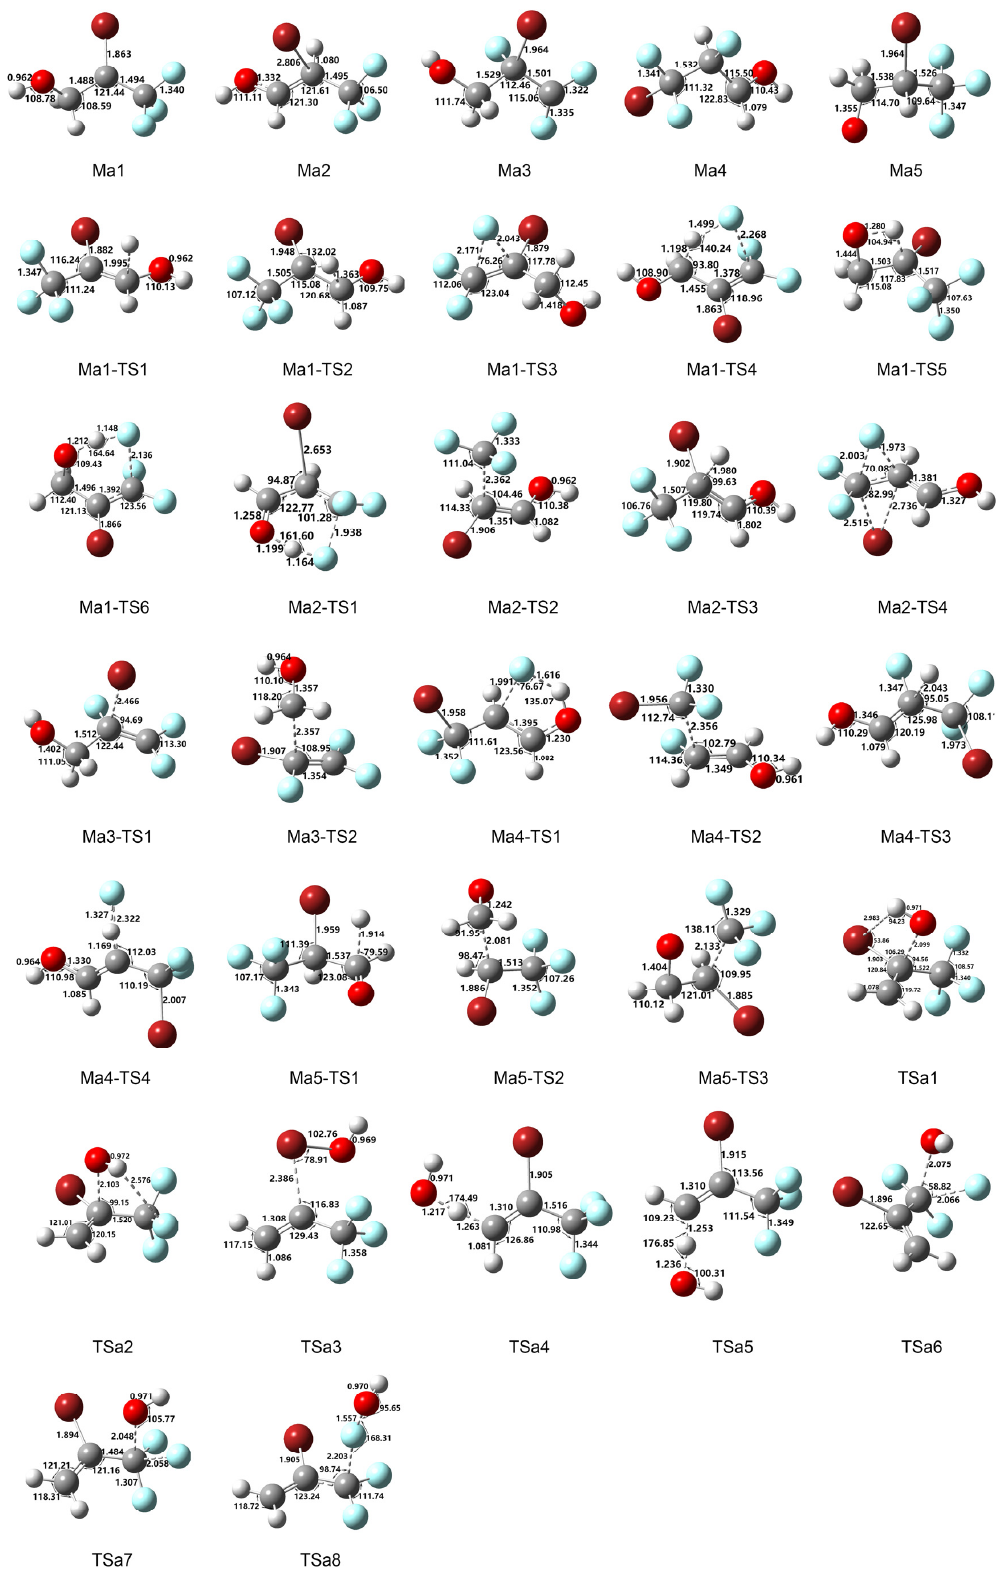
1 Figure 1. Optimized geometries of intermediates and transition states in 2-BTP + OH reaction calculated at B3LYP/aug-cc-pVTZ. Bond lengths and angles are in angstrom and degree,